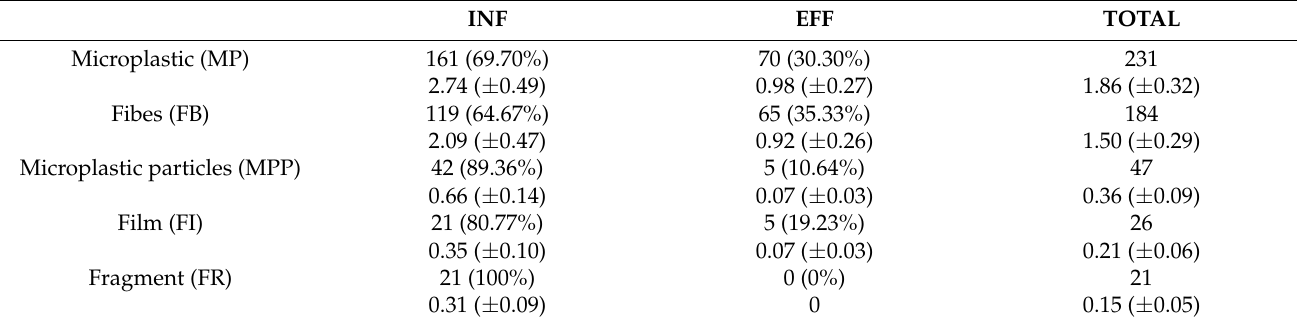
Table 1. Total count, percentages, and average concentrations ( ± standard error) of microplastics in the influent (INF) and effluent (EFF) of “La Aljorra” WWTP. The concentrations are presented in items per liter of wastewater. INF EFF TOTAL Microplastic